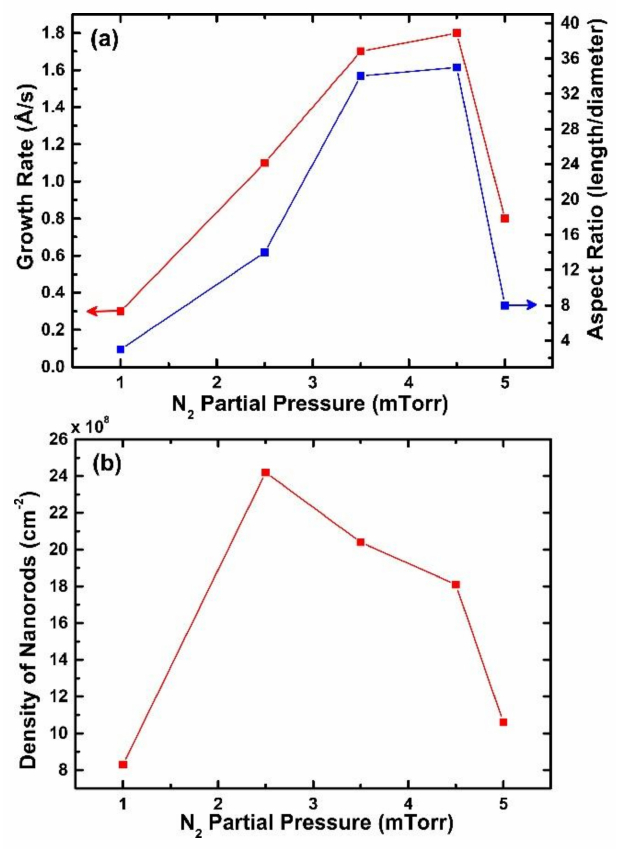
Figure 2. ( a ) Growth rate and aspect ratio and ( b ) variation of density of rods with nitrogen partial pressure, where N 2 partial pressures varying from 5 to 1